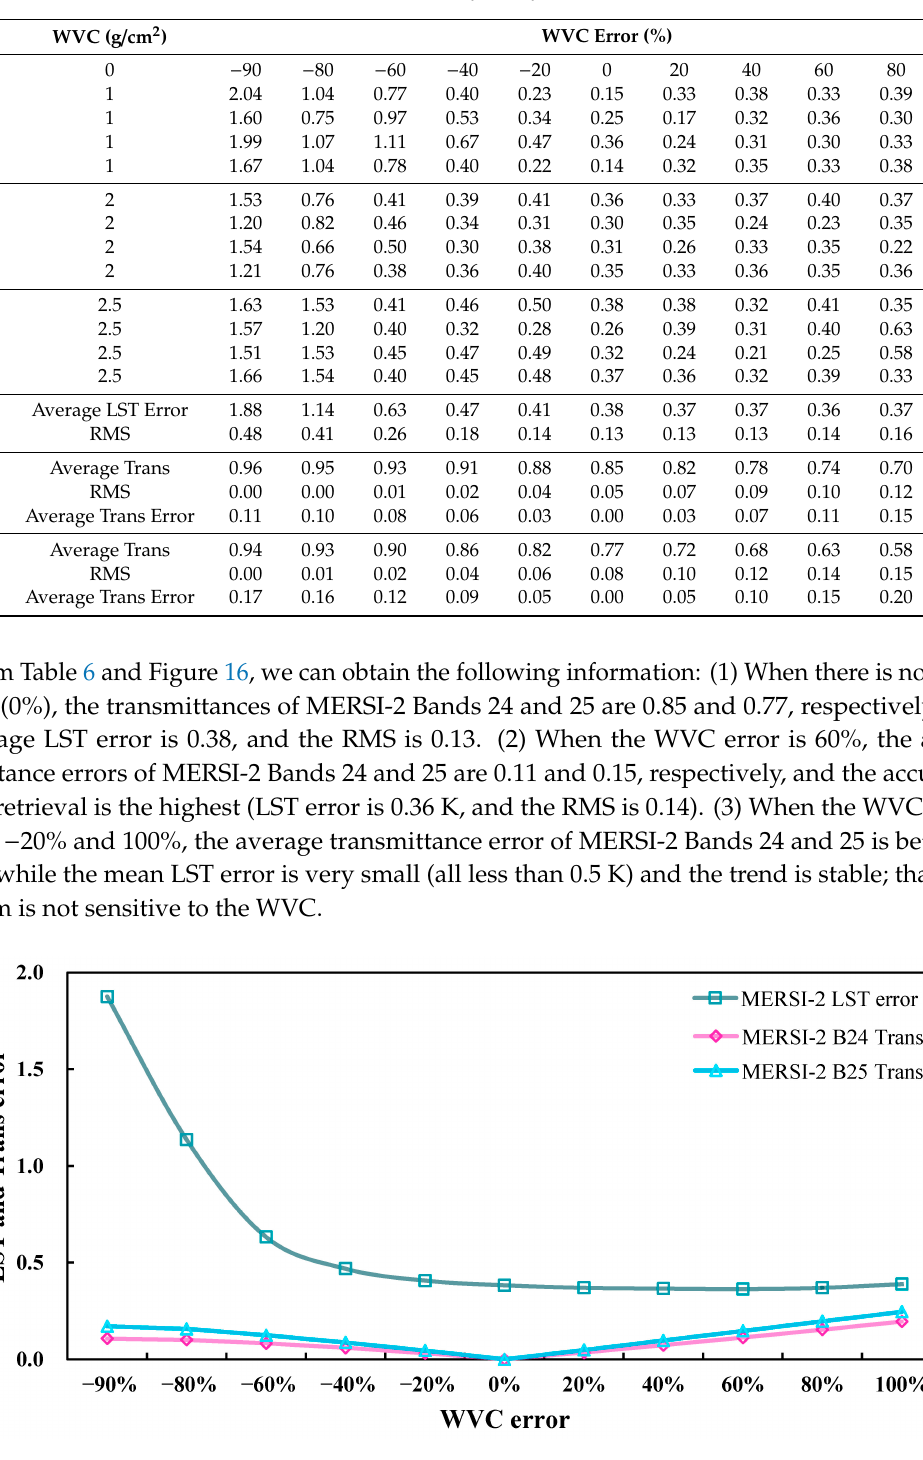
Table 6. The sensitivity analysis of WVC.